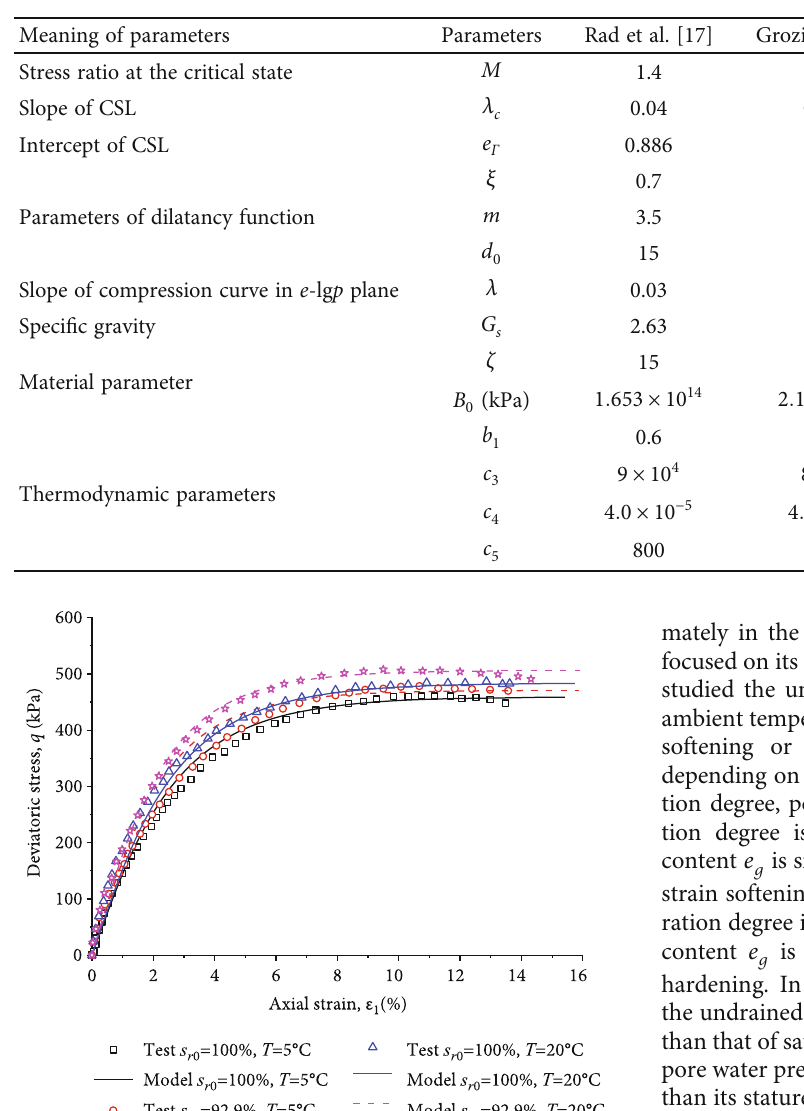
Table 1: Model parameters.